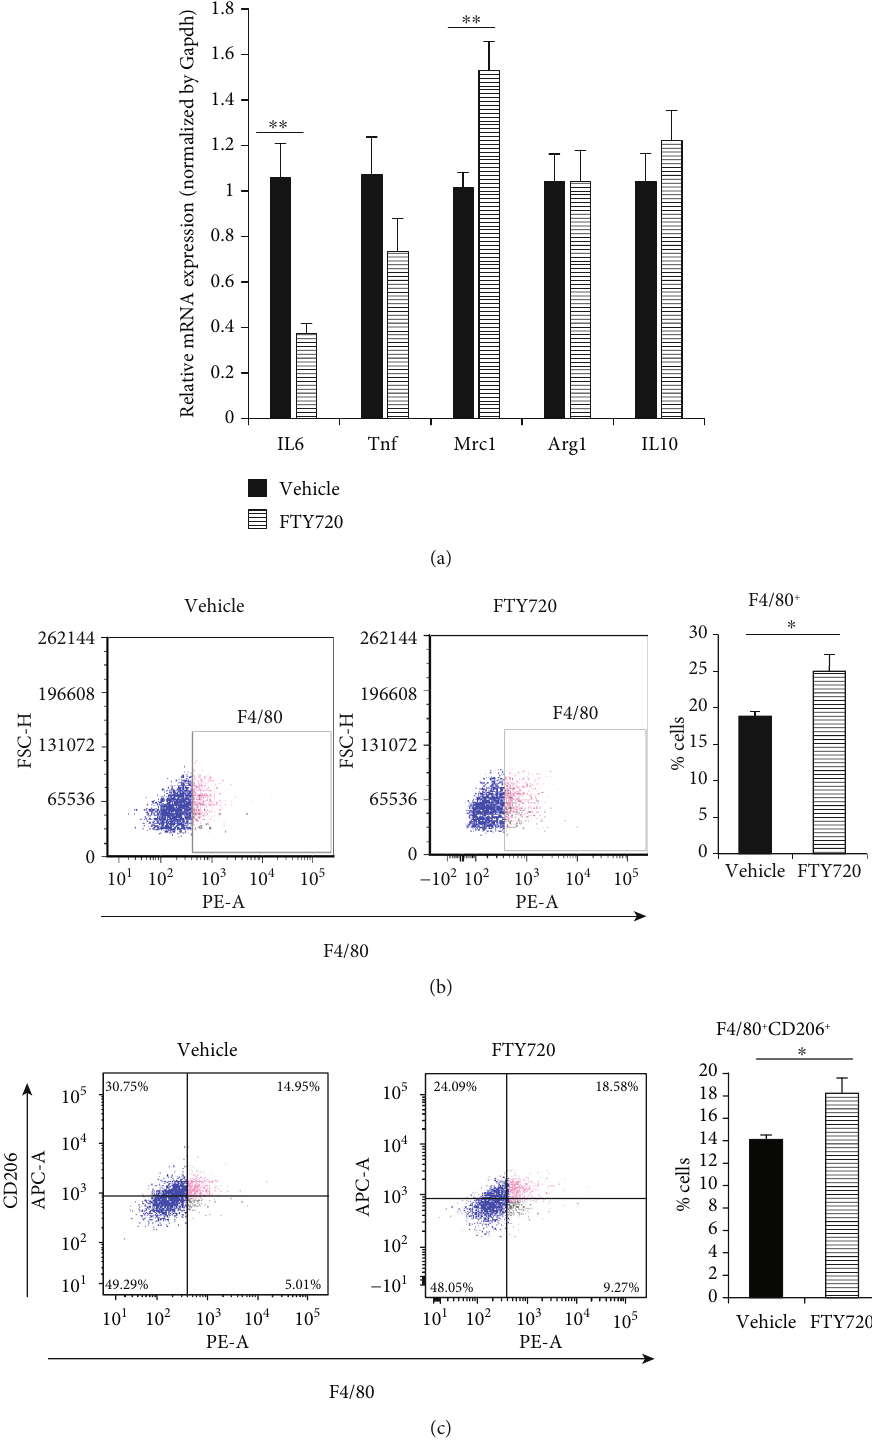
Figure 7: The e ff ect of 2 μ M FTY720 with 100ng/ml LPS in RAW264.7 macrophages. (a) The expression of M1 and M2 marker genes was determined by qRT-PCR ( n = 6 ). (b) Representative fl ow cytometric plots are shown along with the average frequencies of F4/80 + cells. The percentages of F4/80 + cells were determined by fl ow cytometry ( n = 6 ). (c) Representative fl ow cytometric plots are shown along with the average frequencies of F4/80 + CD206 + cells. The percentages of F4/80 + and F4/80 + CD206 + cells were determined by fl ow cytometry ( n = 6 ). Two independent experiments were performed. Both showed similar results. ∗ p < 0 : 05 , as determined by Student ’ s t -test or Welch ’ s t -test after F